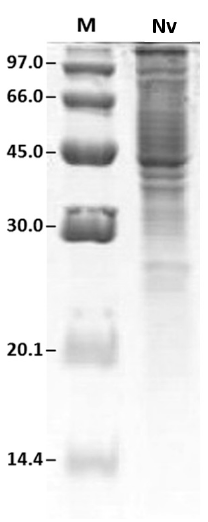
Figure 1. Protein profile of Neoponera villosa ( N. villosa ) venom by SDS-PAGE. M: molecular weight marker (values are displayed on the left, in kDa); Nv: venom of N. villosa .